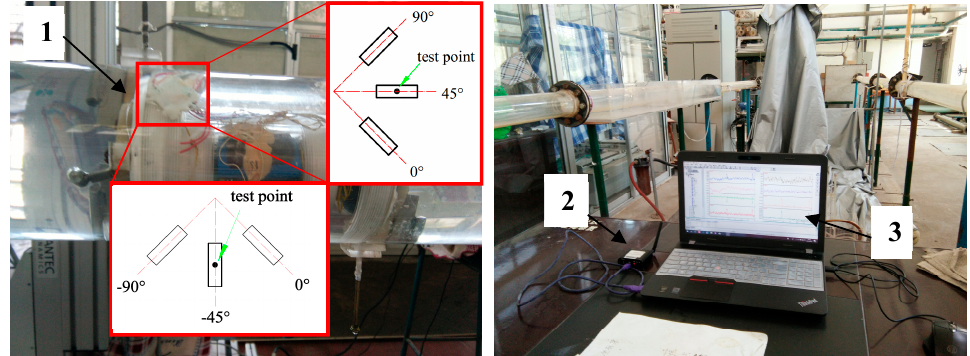
Figure 5. Flow-field measuring-point layout. ( a ) Test section of flow field; ( b ) Measuring points for each section; (1/4 of the test section).